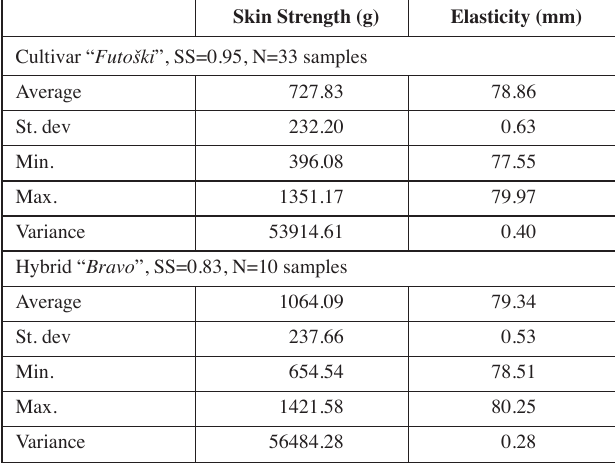
Tab. 4: Texture analysis of cabbage leaves, cultivar “ Futoški ” and hybrid “ Bravo ”. Skin Strength (g)